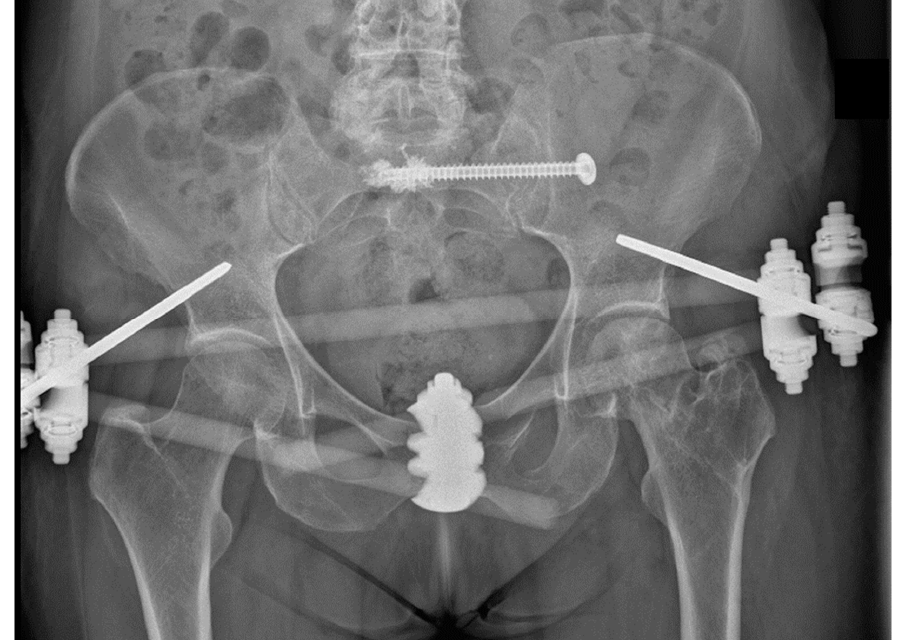
Figure 1. Antero-posterior radiograph demonstrating SI screw fixation of the posterior pelvic ring in a 67-year-old patient who sustained a AO/OTA 61-C1.3, FFP IIc fracture. A bilateral implant